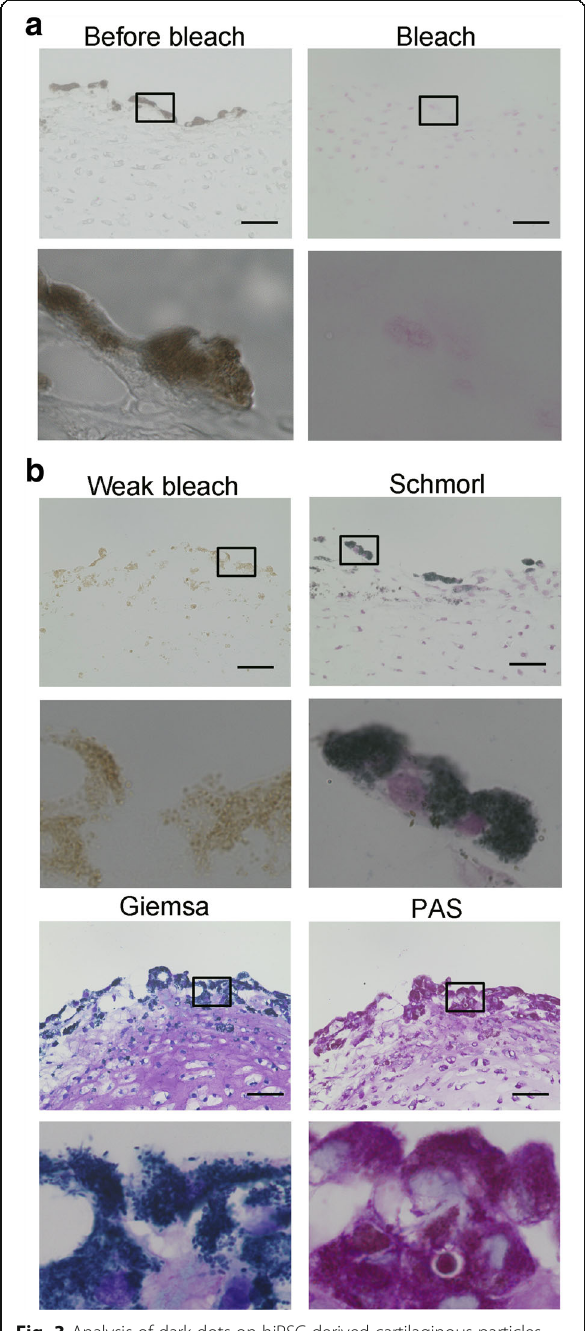
Fig. 3 Analysis of dark dots on hiPSC-derived cartilaginous particles. Histological analysis of a hiPSC-derived cartilaginous particle with dark dots at 12 weeks. a Sections were bleached and counterstained with kernechtrot. b Sections were initially bleached weakly and subjected to PAS staining, Giemsa staining, and Schmorl ’ s reaction. Bars, 50 μ m. Boxed regions are magnified in the images